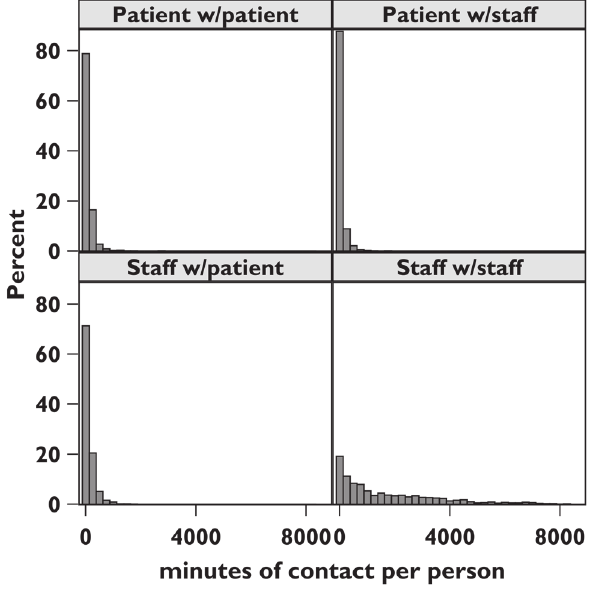
Figure 4. Distributions of the total minutes of contact between participants, by contact